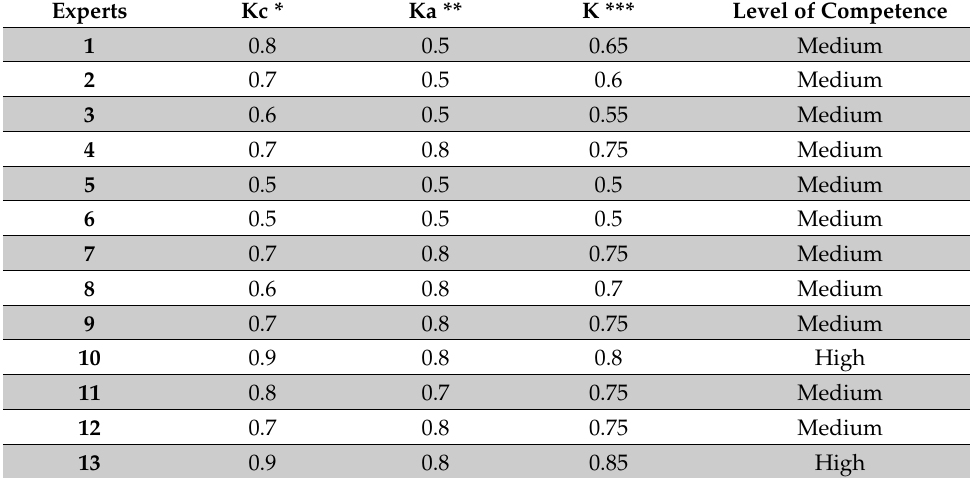
Table 3. Experts’ level of competence.